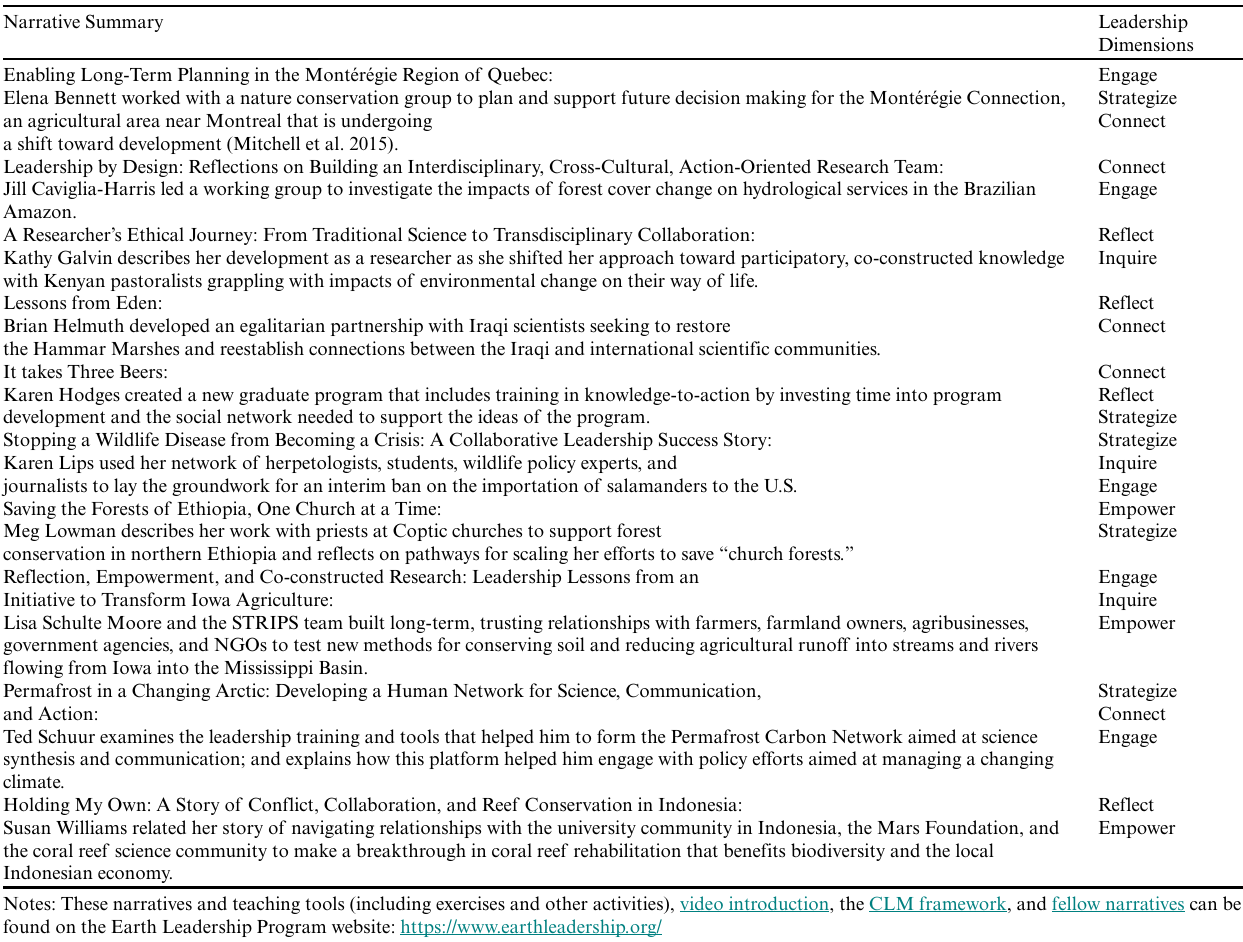
Table 1. Narrative examples with corresponding online teaching